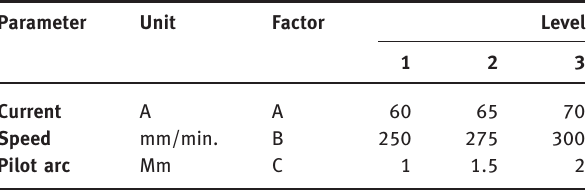
Table 2: Process parameters employed for bead on plate welding.